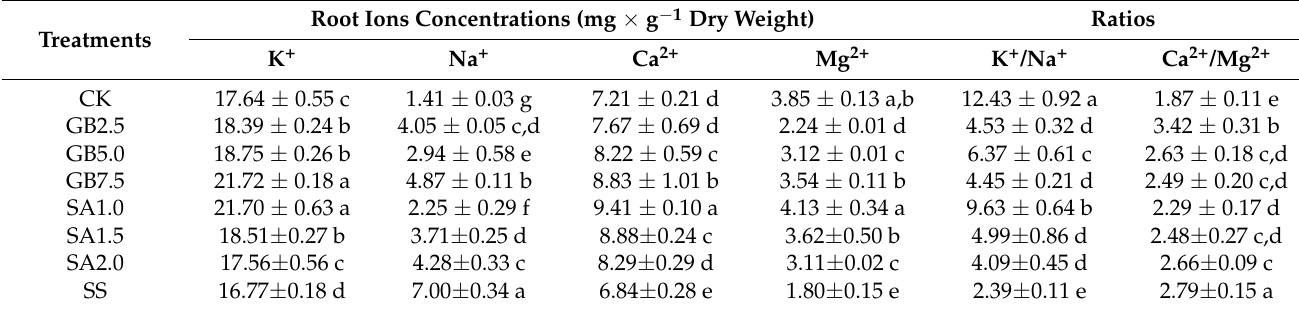
Table 2. Effect of exogenous glycine betaine (GB) and salicylic acid (SA) on root ion concentrations under the 150 mM NaCl regime.